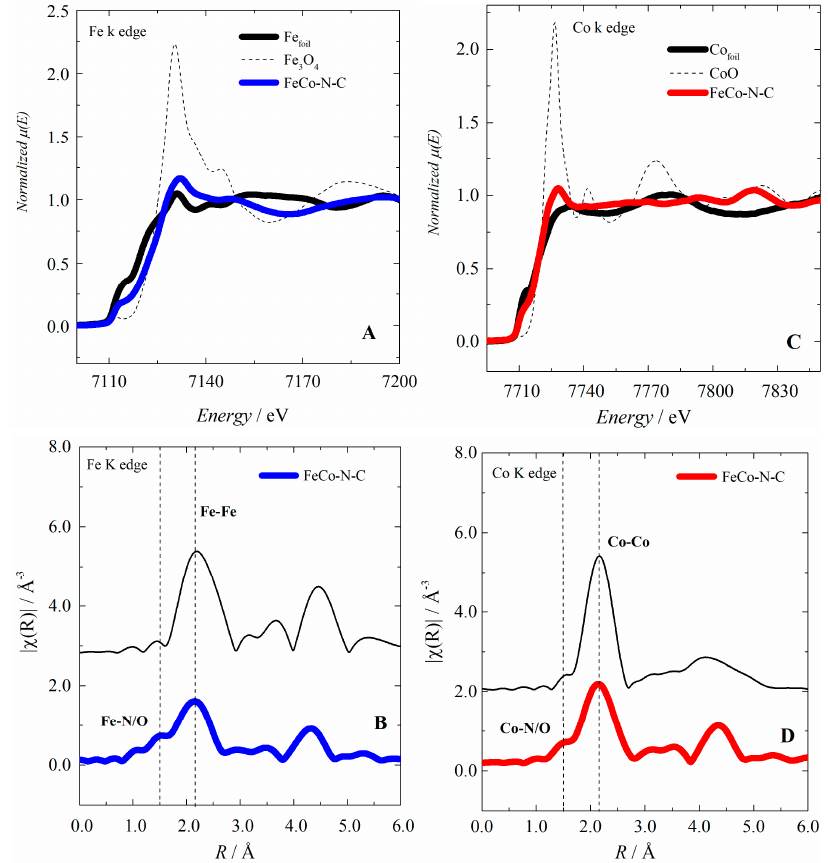
Figure 3. ( A , C ) XANES spectra and ( B , D ) Fourier transforms of the K 2 ‐ weighted EXAFS oscillations measured at the Fe and Co edges for the FeCo ‐ N ‐ C sample. The reference spectra for iron and cobalt oxides and for iron and cobalt bulk metal (Fe and Co foils) were included for comparison.